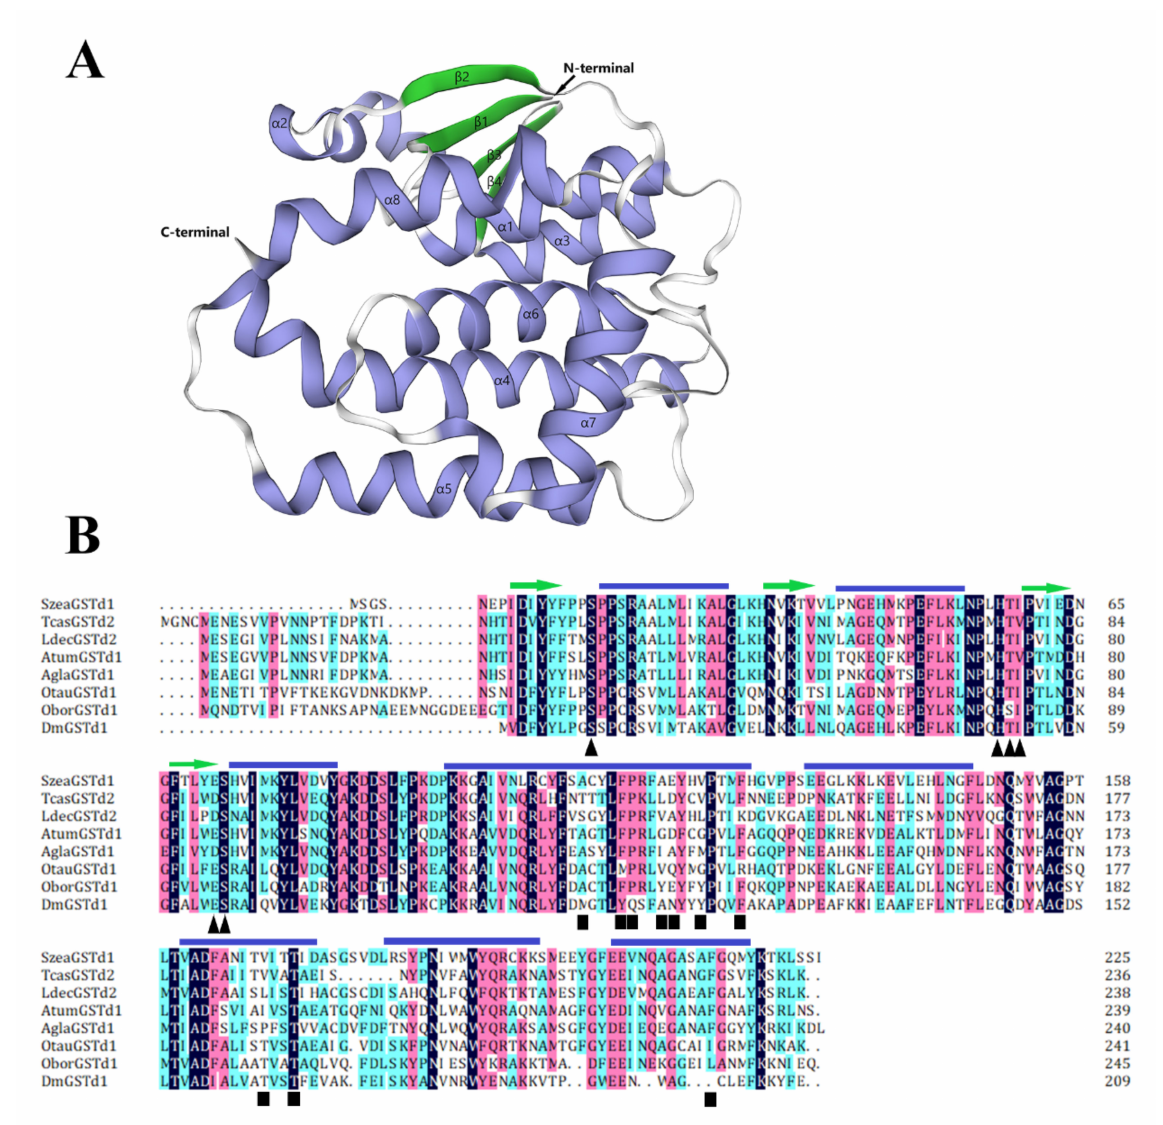
Figure 2. Amino acid sequence structure analysis of SzeaGSTd1. ( A ) The modeled 3D structure of SzeaGSTd1 (DmGSTd1 (Protein Data Bank ID: 3mak [47]) of D. melanogaster is the structural template). The α -helices and β -sheets were labeled with α and β , respectively. ( B ) Sequence alignment of delta- class GSTs from insects. Black triangles indicate amino acid residues that comprise the G site and black squares indicate the amino acid residues that comprise the H site. The position of β -sheets ( β 1- β 4, indicated by the green arrow) and α -helices ( α 1- α 8, indicated by the blue line segment) in the SzeaGSTd1 protein sequence is shown on top of the alignment. TcasGSTd2 from T. castaneum , QES86455.1; LdecGSTd2 from Leptinotarsa decemlineata , XP_023021411.1; AtumGSTd1 from Aethina tumida , XP_019870085.1; AglaGSTd1 from Anoplophora glabripennis , XP_018560761.1; OtauGSTd1 from Onthophagus taurus , XP_022909213.1; OborGSTd1 from Oryctes borbonicus , KRT81939.1; DmGSTd2 from D. melanogaster ,